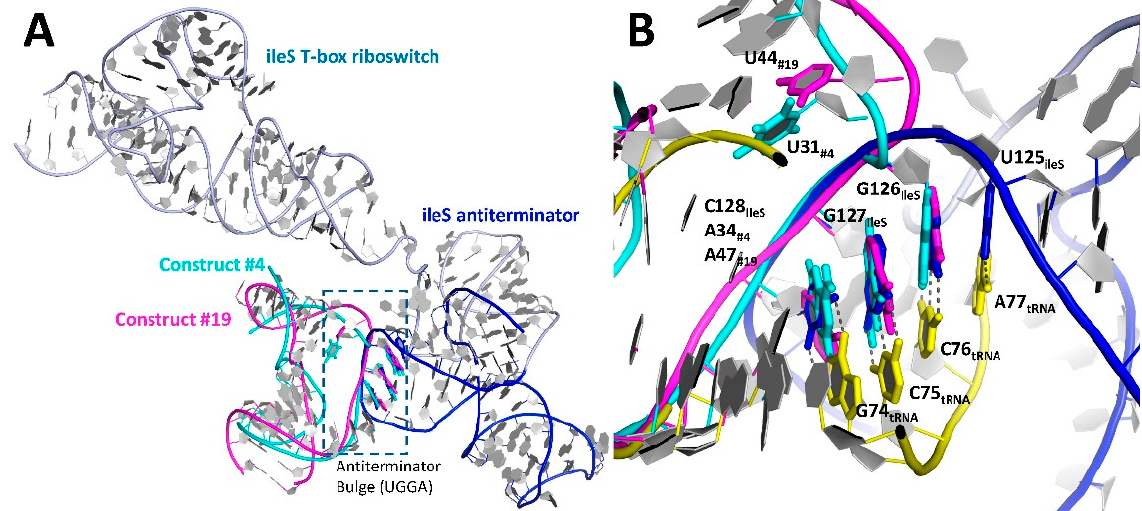
Figure 4. Comparison of the fusion antiterminator and ileS T-box riboswitch-tRNA co-crystal struc- tures. ( A ) The tRNA acceptor stem-binding bases, UGGA, were superposed from the ileS T-box riboswitch structure (light blue, PDB ID: 6UFG), and the structures of Constructs #4 (cyan) and #19 (magenta). The antiterminator bulges are highlighted by a dashed box. ( B ) Close up of the UGGA motif from the antiterminator bulge and its interaction with tRNA (yellow) in the ileS T-box riboswitch structure. Nucleotides are numbered according to numbering in deposited coordinate files and are colored as in Panel A.